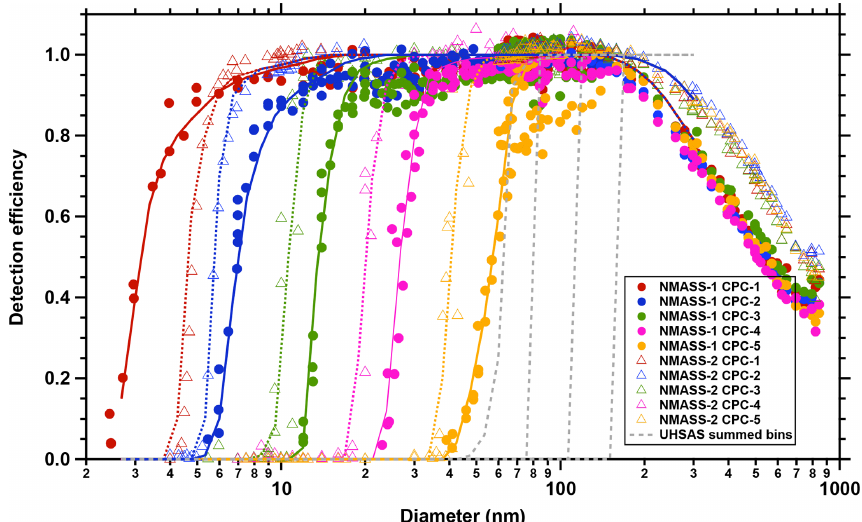
Figure 2. Detection efficiencies for the five CPCs in each of two NMASS instruments as operated beginning in ATom-2. Scatter in the points shows repeatability from multiple calibrations. Lines are fits used as K i (D p ) in the inversion of Eq. (5). Cumulative bins from the UHSAS instrument (dashed grey lines) are used in the inversion of NMASS data to recover a size distribution for diameters from 2.7 to 300nm. Decreases in detection efficiency for diameters >150nm are due to impaction losses in the pressure reduction section, and are different for the two NMASSs. During ATom-1 only the NMASS-1 instrument was